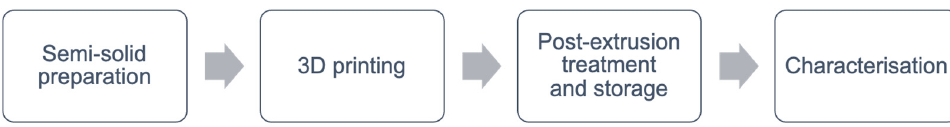
Figure 1. Graphic illustration of ODMT production via SSE.